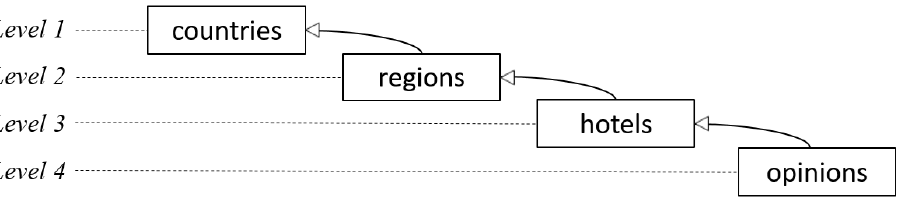
Fig. 2. The overall structure of the travel agency web portal.